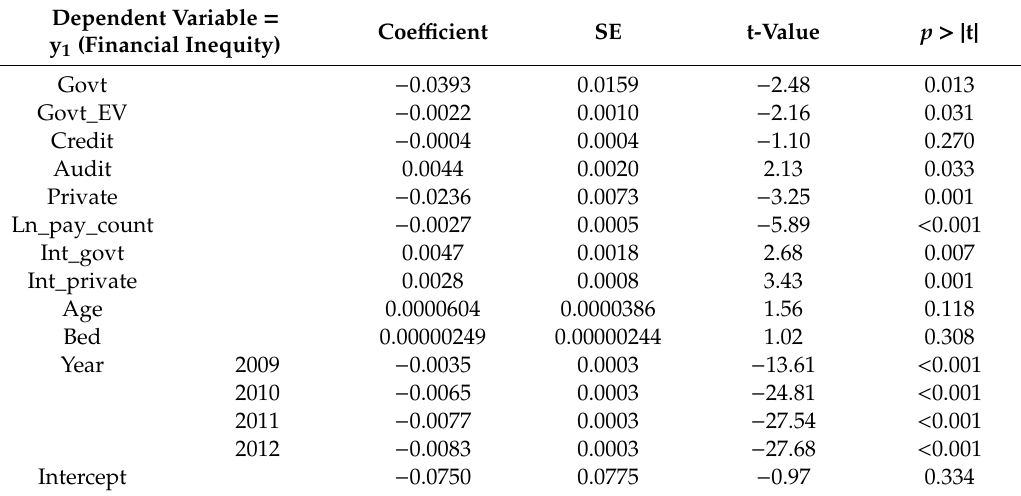
Table 7. Fixed e ff ects regression of publicness on financial